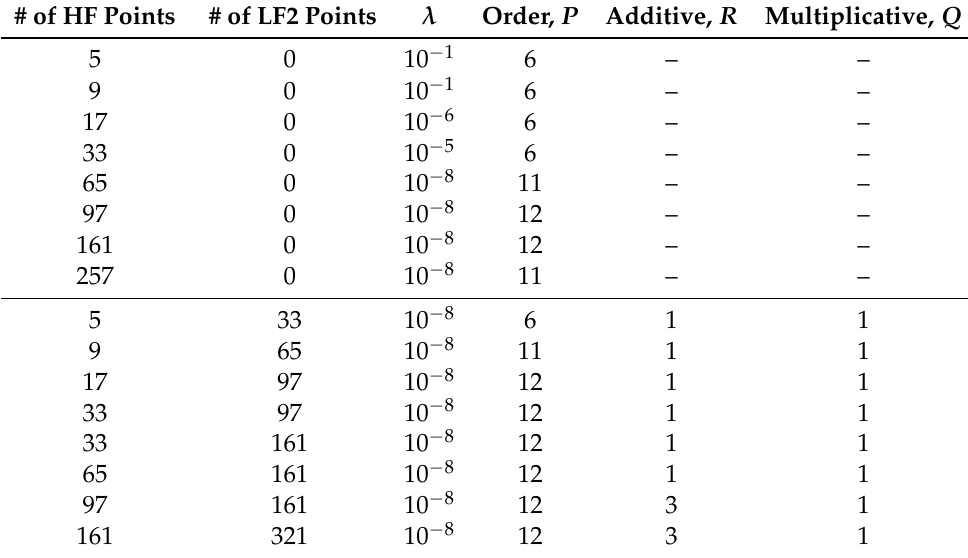
Table 5. Best order and λ values for the two-dimensional ALOS function using MF SPCE. # of HF